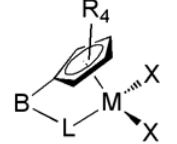
Figure 1. The constrained geometry catalyst (B: bridging unit, L: donating ligand and X: halide).